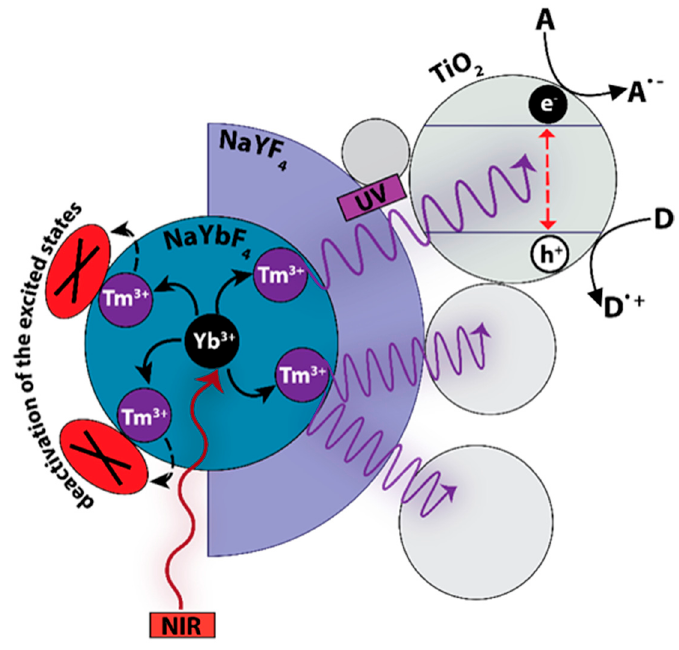
Figure 6. The proposed mechanism of the NIR-driven photocatalytic reaction in the presence of the examined core and core–shell upconverting particles (D denotes an electron donor, such as H 2 O or OH − ions; A denotes an electron acceptor, such as O 2 ).